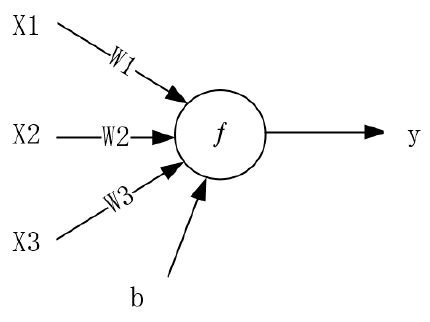
Figure 1. Working principle of neurons.